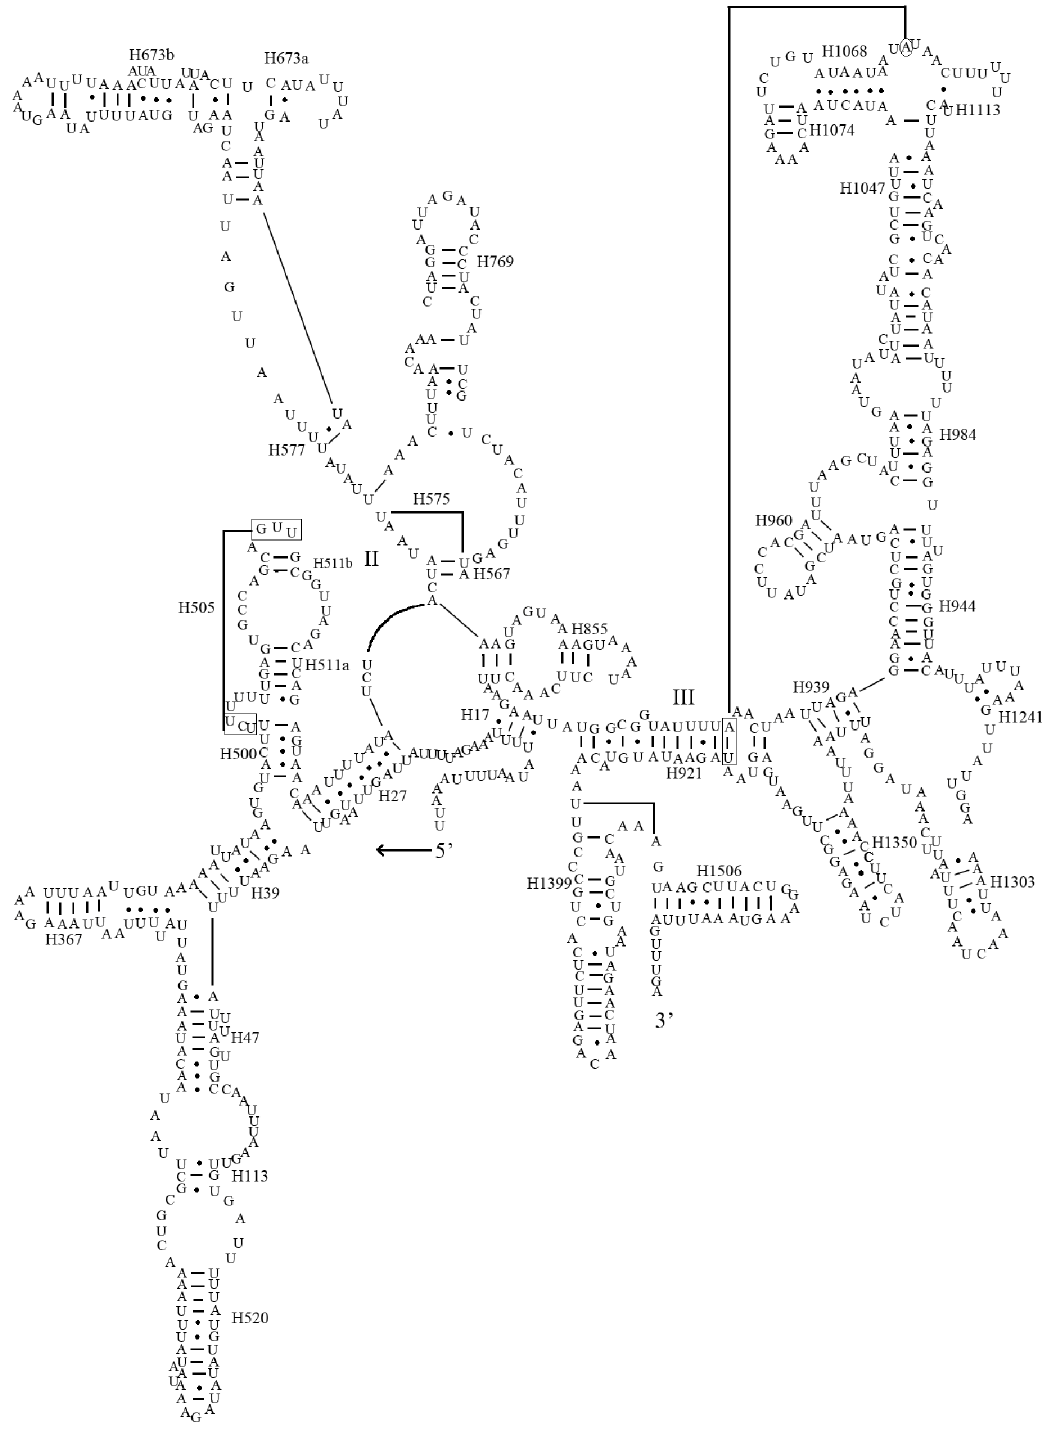
Fig 6. Predicted secondary structure of rrnS in the A . spiniferus mitogenome. Tertiary interactions and base triples are illustrated with continuous lines. Base-pairing is indicated as follows: Watson-Crick pairs, lines; GU pairs, dots; other non-canonical pairs,